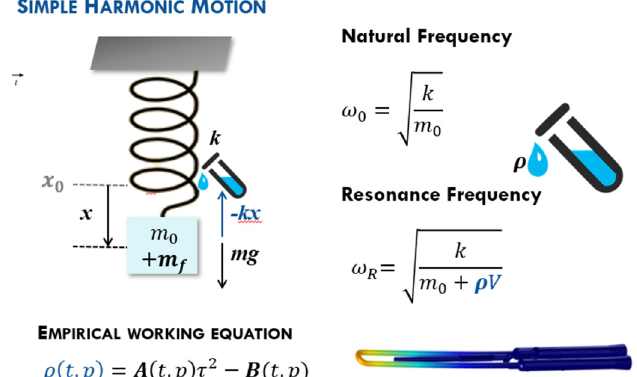
Fig. 1. Schematics and equations of the simple harmonic motion of the oscillation-type density meter cell fi lled with a fl uid of density r (adapted